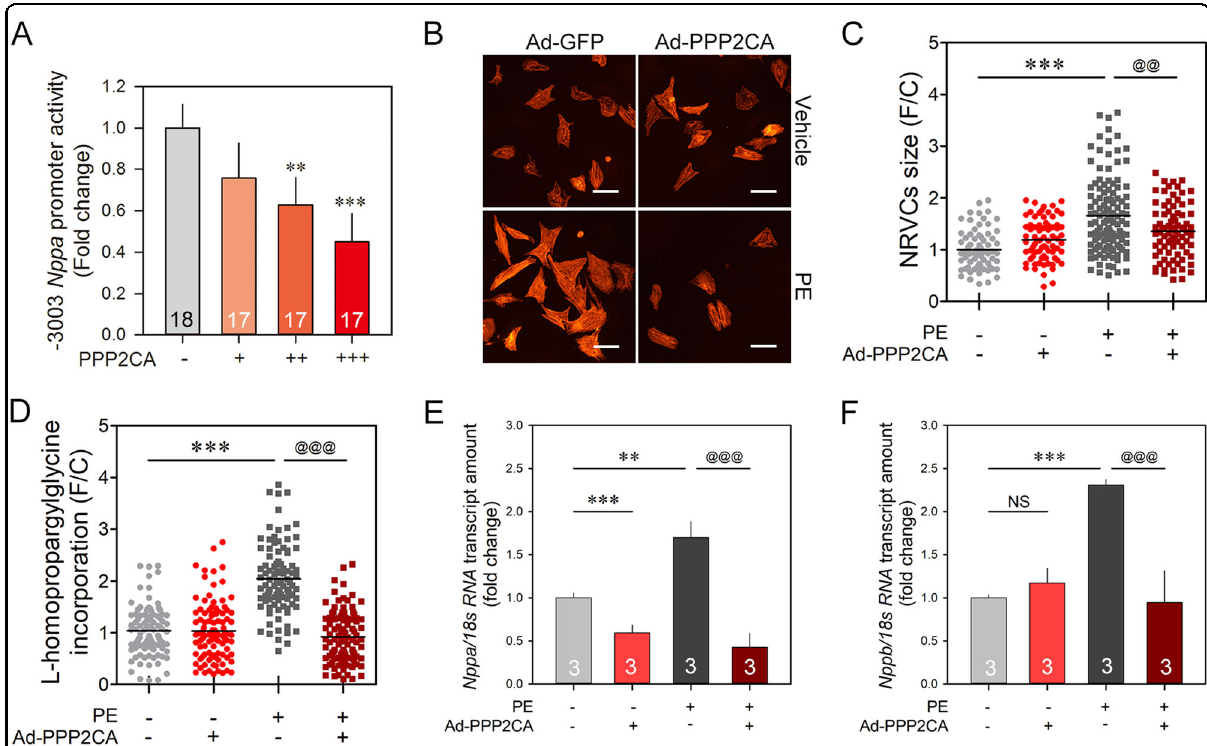
Fig. 4 PPP2CA negatively regulates hypertrophic responses. a – 3003 Nppa reporter activity in H9c2 cells was decreased in a PPP2CA dose- dependent manner. b , c Cell size measurement in NRVCs. Cardiomyocyte-speci fi c sarcomeric alpha-actinin was visualized by immunocytochemistry analysis. Treatment with 20 μ mol/L PE induced an increase in the cell surface area, a hallmark of cardiomyocyte hypertrophy. Ad-PPP2CA abolished the PE-induced cell size enlargement. The dots depict individual cell size. d De novo protein synthesis was evaluated by quanti fi cation of the incorporation of L -homopropargylglycine (HPG) in NRVCs. NRVCs were infected with Ad-PPP2CA for 48 h and exposed to 20 μ mol/L PE. Cells were cultured in HPG-containing methionine-free medium for 1 h, and then the incorporated HPG was ligated to Alexa Fluor 594 azide for visualization. The signal density of the cells was determined by fl uorescence microscopy and then quanti fi ed using software. Ad-PPP2CA signi fi cantly attenuated de novo protein synthesis driven by PE. e , f PE-induced early hypertrophic marker gene expression was regulated by Ad-PPP2CA. Both Nppa ( e ) and Nppb ( f ) were successfully increased by PE stimuli, which was blocked by infection of Ad-PPP2CA. Numbers in the bars ( a , e , f ) indicate the experimental set. White scale bars indicate 15 μ m. @@ indicates p < 0.01. *** and @@@ depict p <